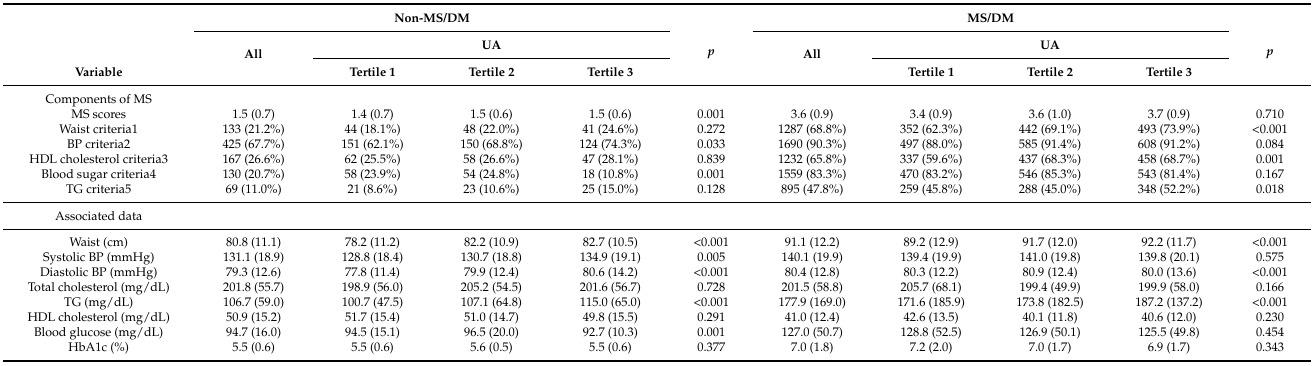
Table 2. MS components are divided by MS/DM and uric acid tertiles.